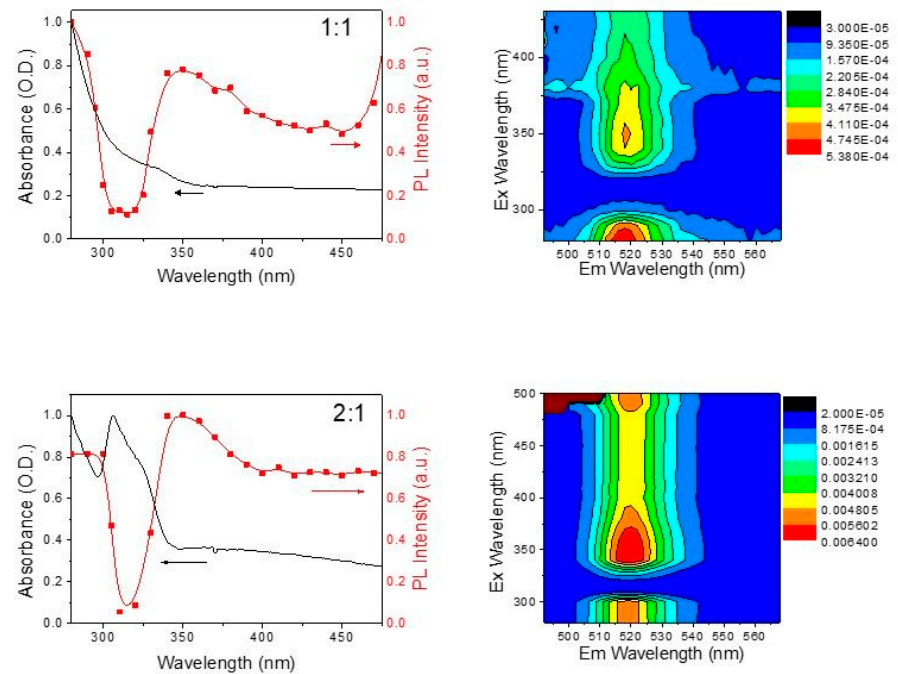
Figure 9. Excitation spectra ( λ em = 520 nm, red squares) and contour curves of the fluorescence for 1:1 and 2:1 samples. The respective absorption spectra (black lines) from Figure 6 are also reported for comparison.